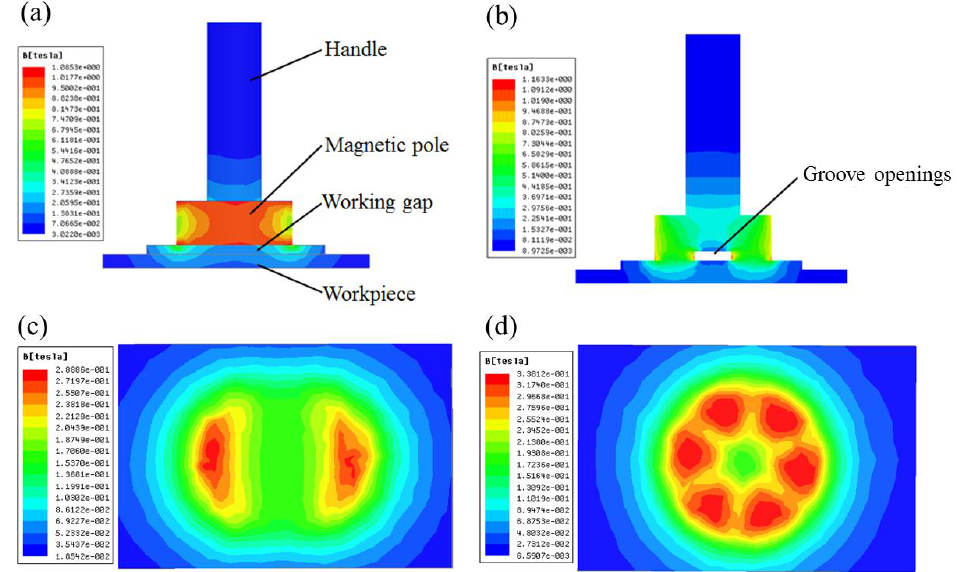
Figure 4. Simulation results: ( a ) model of cylindrical magnetic pole; ( b ) model of cylindrical mag- netic pole with grooves; ( c ) magnetic flux density on workpiece surface performed at model ( a ); ( d ) magnetic flux density on workpiece surface performed at model ( b ).